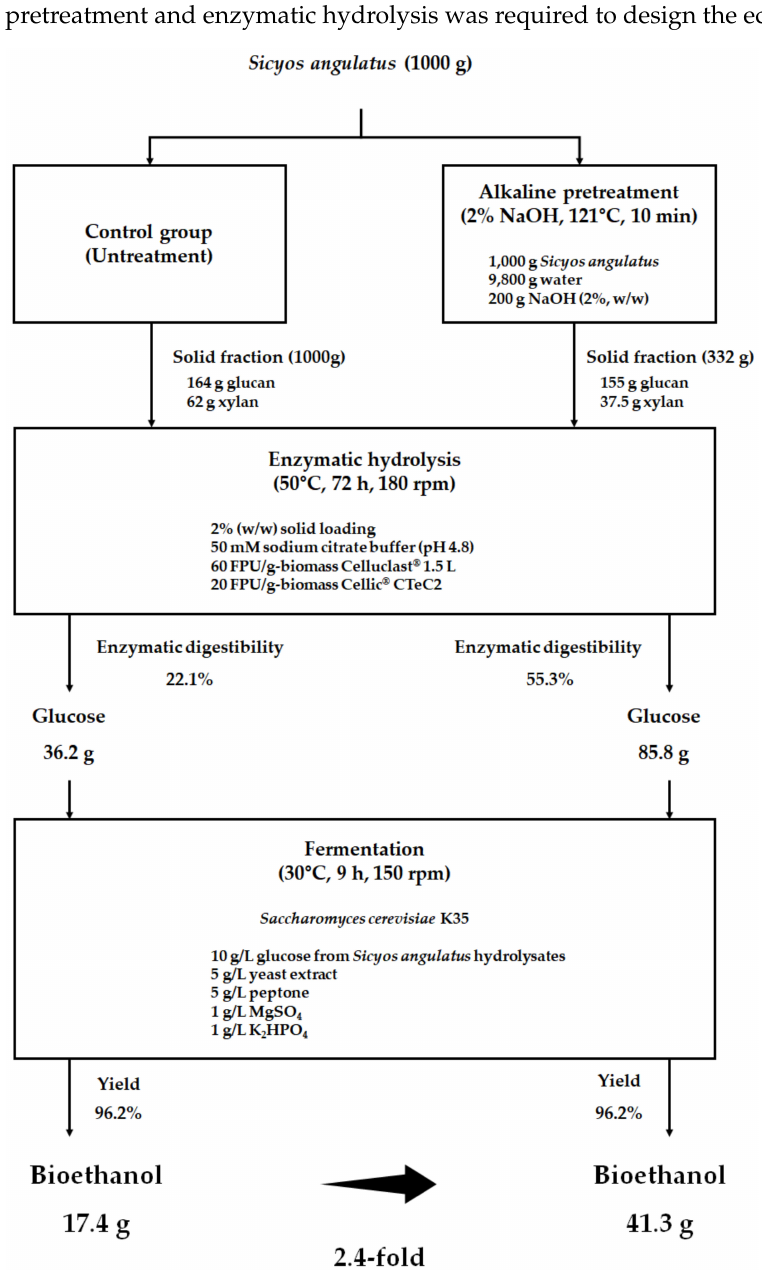
Figure 4. Material balance of bioethanol production from biomass based on 1000 g Sicyos angulatus